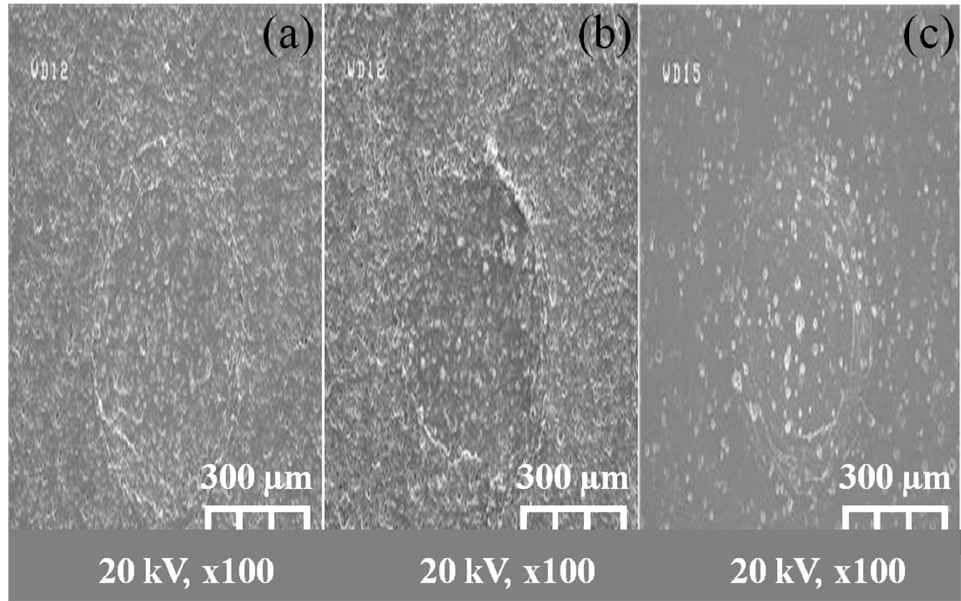
Figure 3. Results of the hardness test for ( a ) sample A, ( b ) sample B, and ( c ) sample C. Table 3. X-ray fluorescence (XRF) studies of the porcelain body of porcelain insulators. Constituents (wt.%)